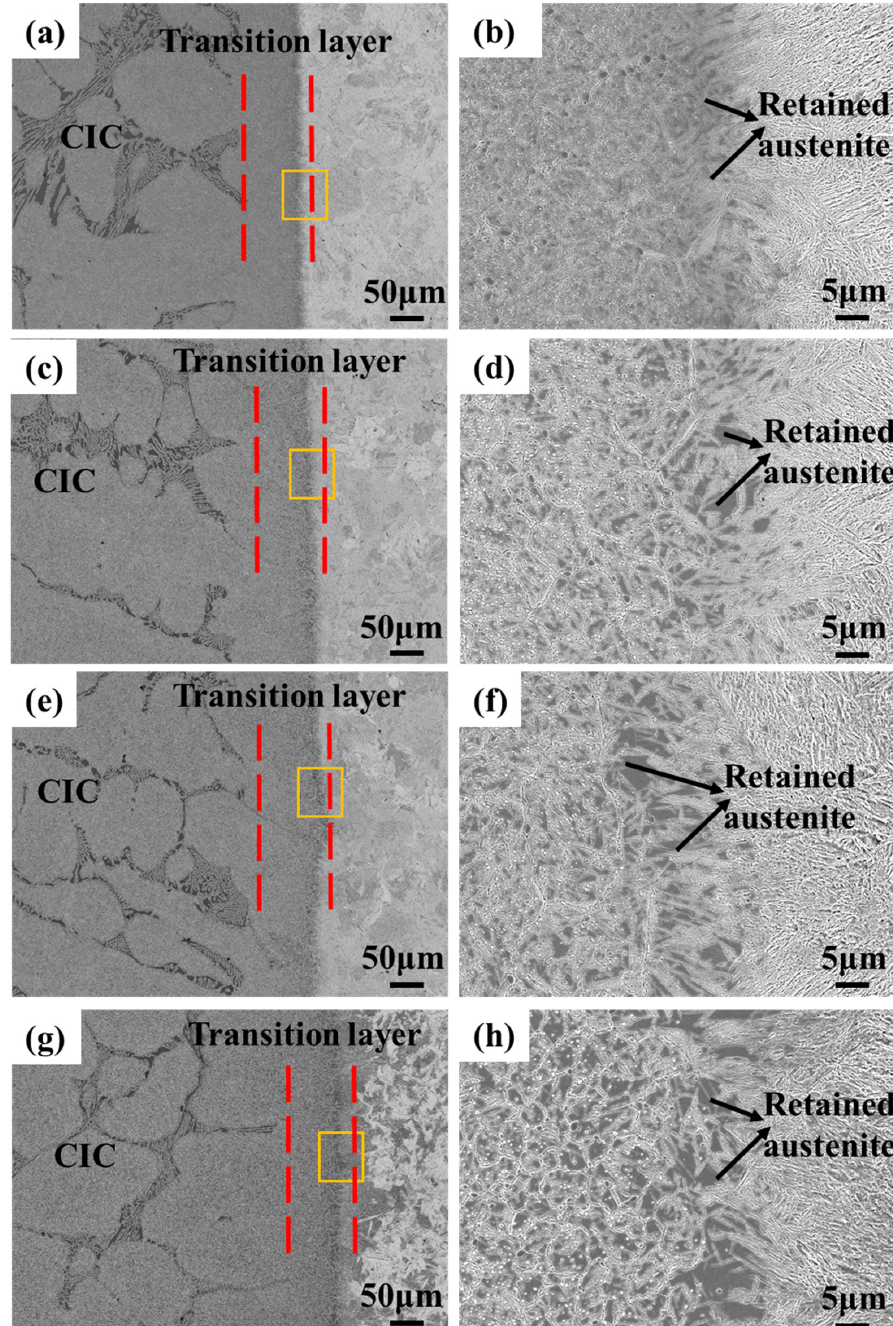
Figure 8. SEM images of the samples with different Ni content in CICs after heat treatment: ( a , b ) CIC ‐ 1; ( c , d ) CIC ‐ 2; ( e , f ) CIC ‐ 3; ( g , h ) CIC ‐ 4.